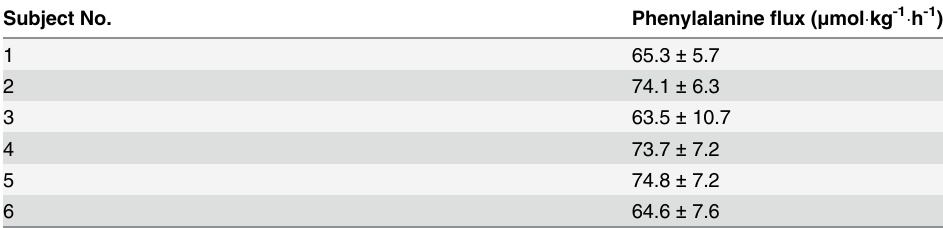
Table 5. The effect of protein intake on phenylalanine fluxes. Values are means ± SD. No significant dif- ferences (P > 0.05) in phenylalanine flux were observed within each participant because of various test pro- tein